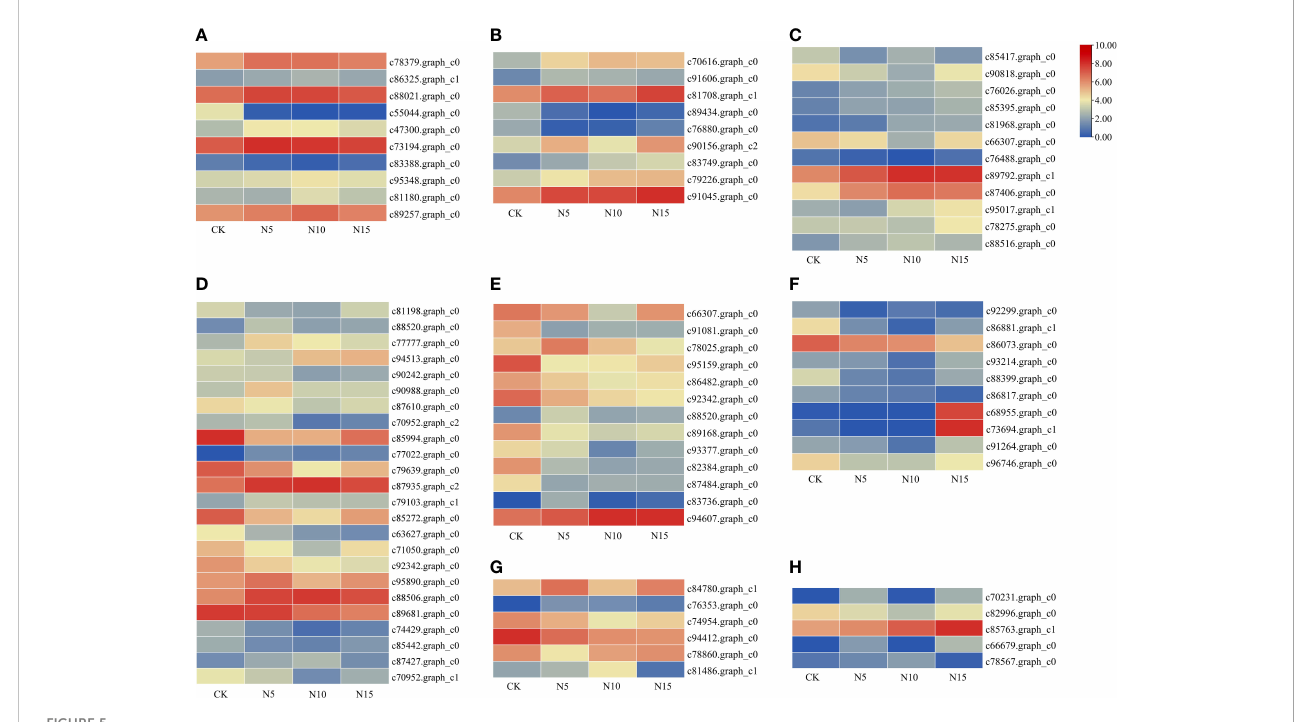
FIGURE 5 The expression pro fi le of collected functional genes in various N level environments. (A) Photosynthesis; (B) Auxin; (C) Circadian rhythm; (D) Phenylpropanoid biosynthesis; (E) Flavonoids synthesis; (F) sesquiterpenoid and triterpenoid biosynthesis; (G) diterpenoid biosynthesis; (H) monoterpenoid